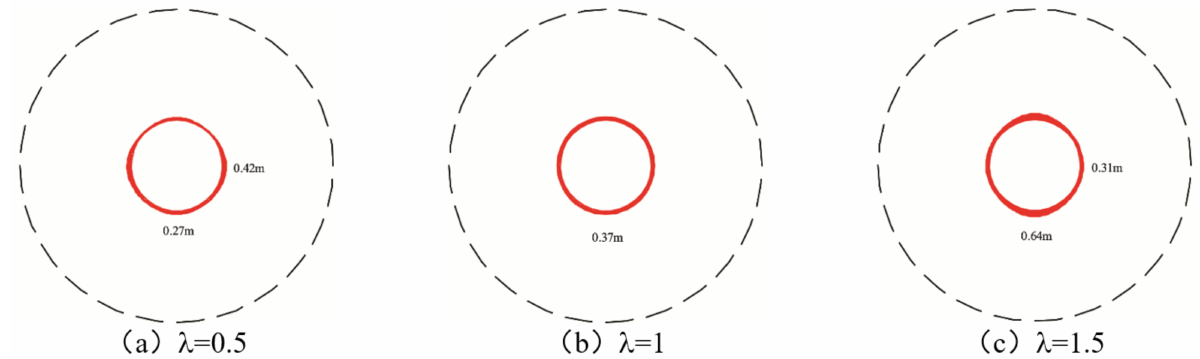
Figure 7. Range of extremely strong rockburst when σ v = 30 Mpa: ( a ) σ H / σ v = 0.5; ( b ) σ H / σ v = 1.0; ( c ) σ H / σ v = 1.5.